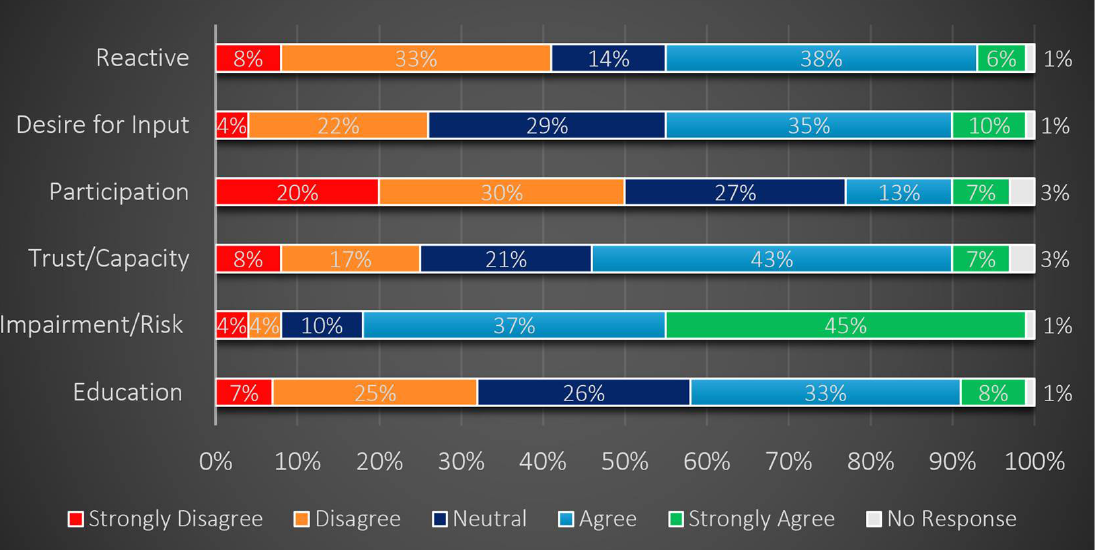
Table 4. Citizen assessments of significant watershed management groups.